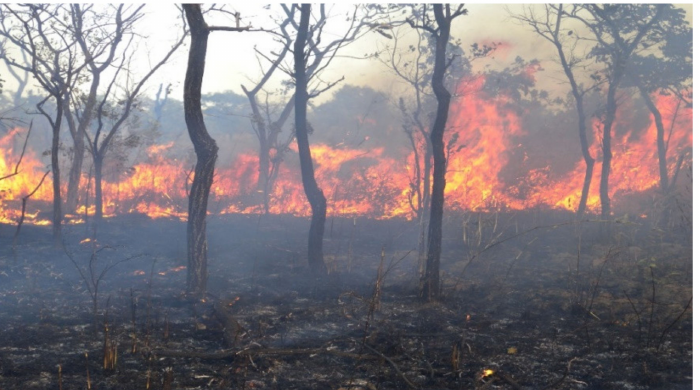
Figure 2. A mid-season head fire in a wooded savanna in Faradi é l é , Mali. Note the flame height is relatively high (>2 m), indicating a high-intensity, wind-driven head fire. Smoke indicates a lower combustion efficiency even though burned area and combustion completeness appear very high (Photograph by P.